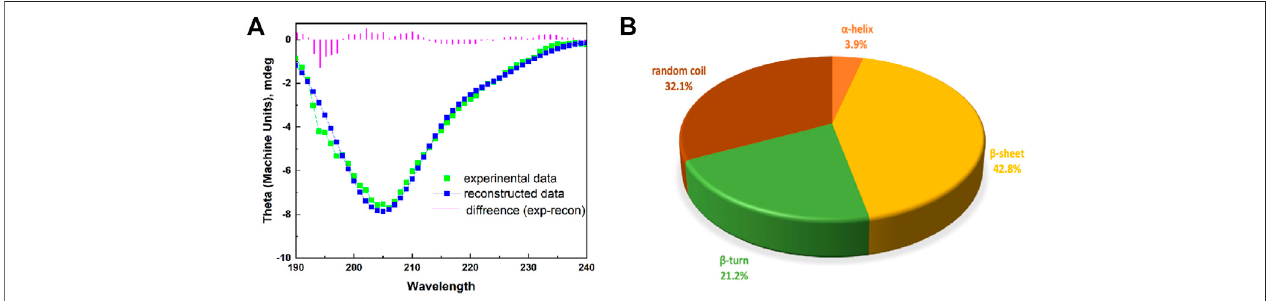
FIGURE3| ThesecondarystructureofEPF3. (A) :AmodeledCDspectrumofEPF3byDichrowebonlinetoolwithK2Dalgorithm.Thespectraincludeexperimental data (green color), reconstructed data (blue color), and the difference (violet color). (B) : A pie graph representing various forms of secondary structure in EPF3.